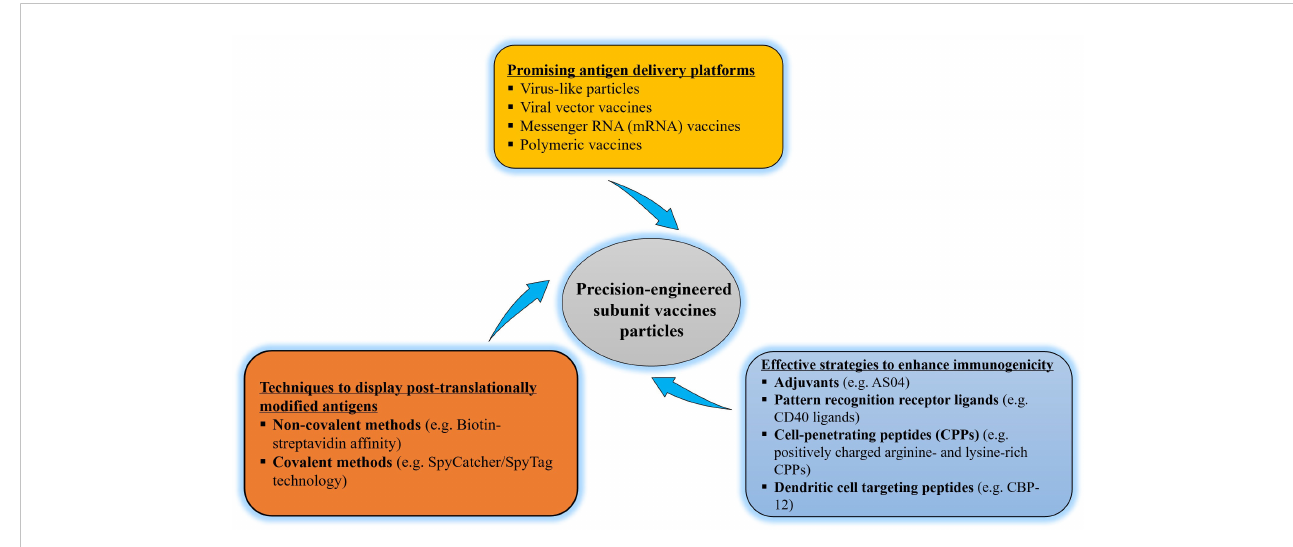
FIGURE 2 Flow diagram of precision-engineering of subunit vaccine